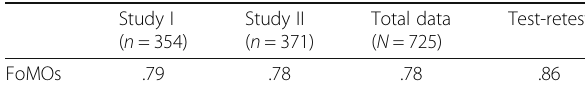
Table 3 Reliability results of the